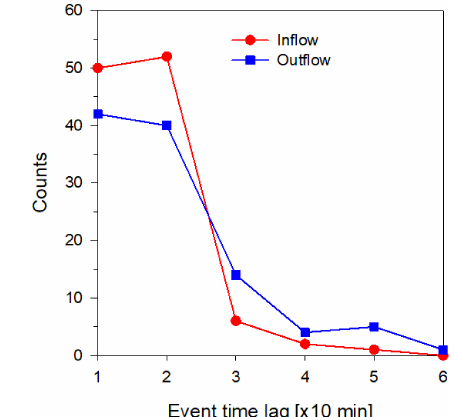
Figure 5. Time lags between changes in d P atm / d t (i.e., changes in barometric pressure over time) and the start of inflow–outflow events. Event classification was done automatically using the data from the 12m depth sensors. Red symbols represent the time lag between the transition of d P atm / d t from negative to positive values and the start of an inflow event (stages 1 and 3 in Fig. 4). Blue symbols represent the time lag between the transition of d P atm / d t from positive to negative values and the start of an outflow event (stages 4 and 6 in Fig.